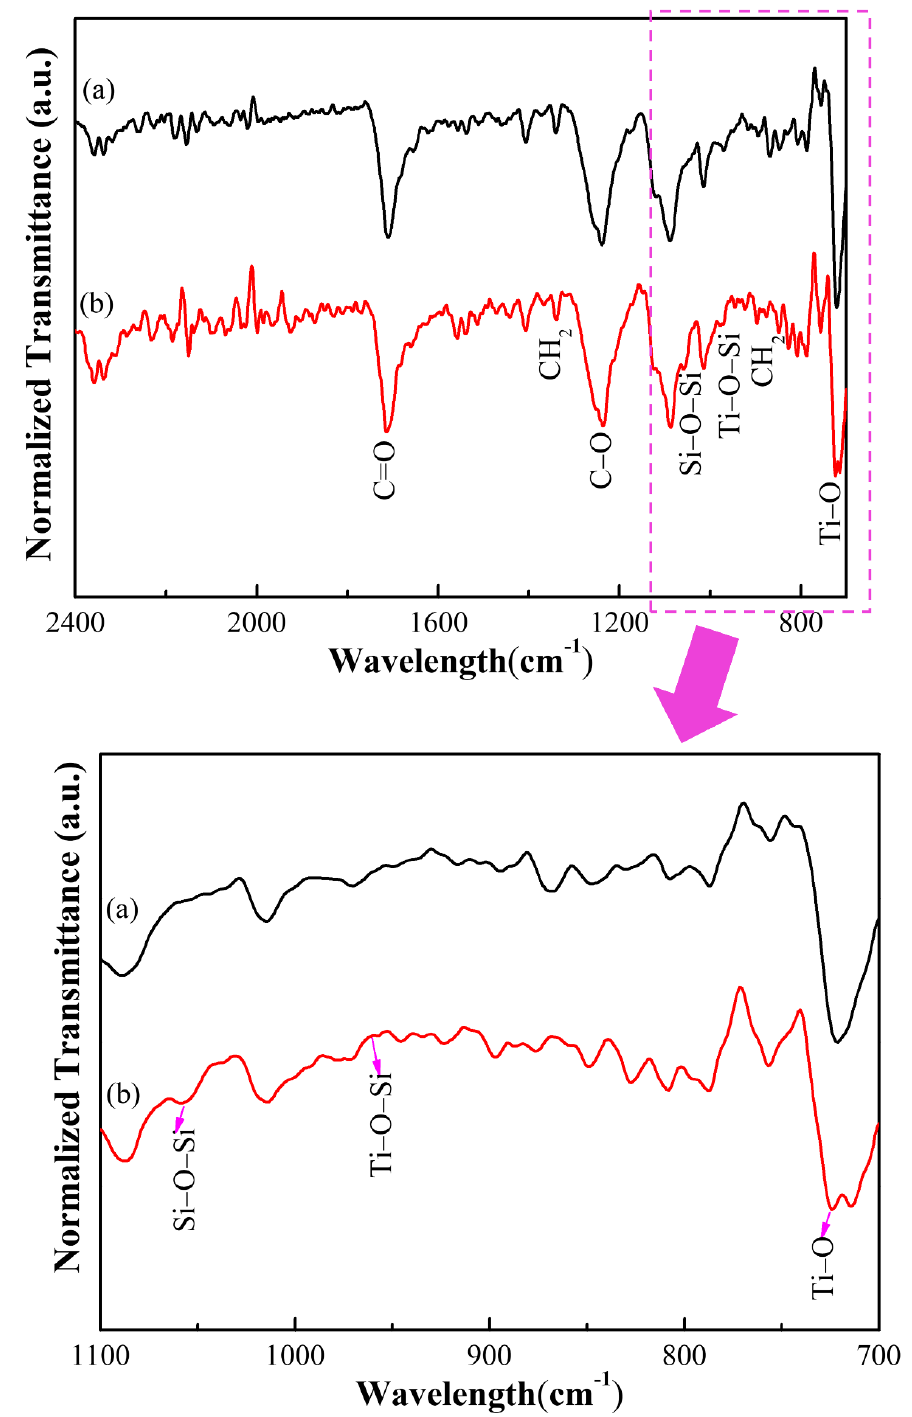
Figure 9. Infrared spectra of photocatalytic materials (a) polyester fabric, (b) Y 2 O 3 /TiO 2 -loaded polyester fabric.